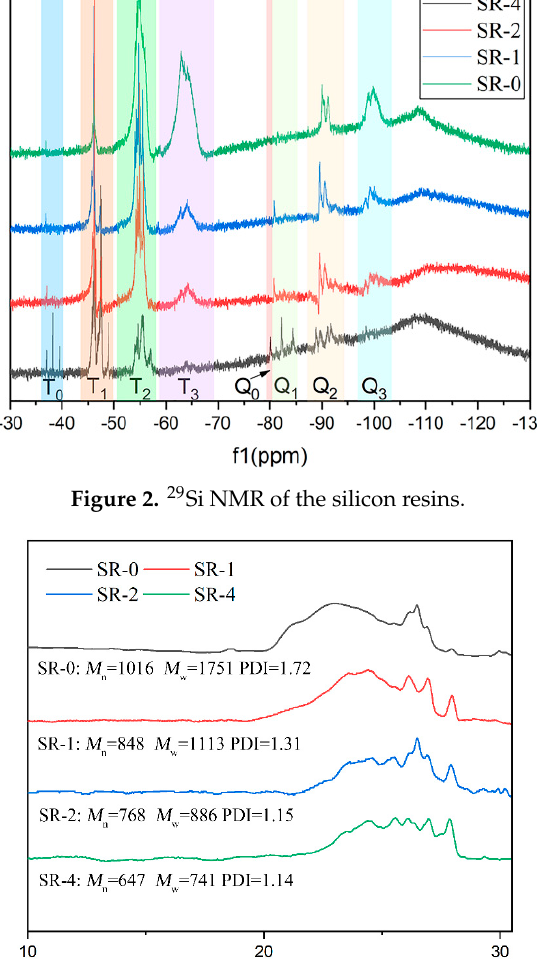
Figure 3. GPC spectra of silicon resins.